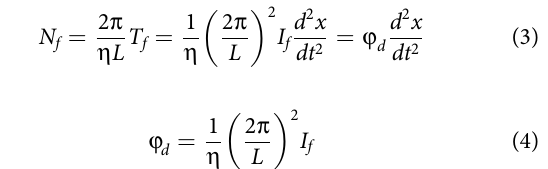
where I f denotes the moment of inertia of the flywheel. The